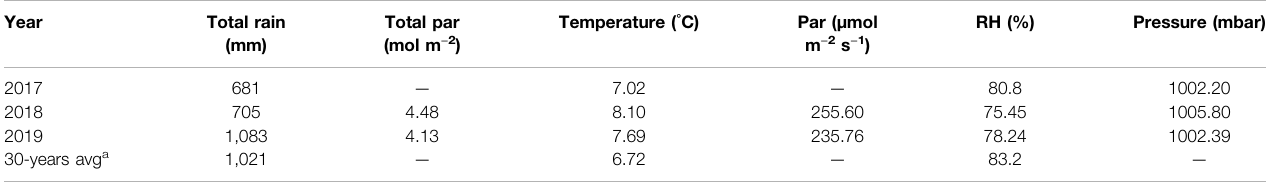
TABLE 1 | Summary of meteorological conditions at Mycklemossen in 2017, 2018, 2019, and 1990 – 2019. Values are annual means unless otherwise stated.